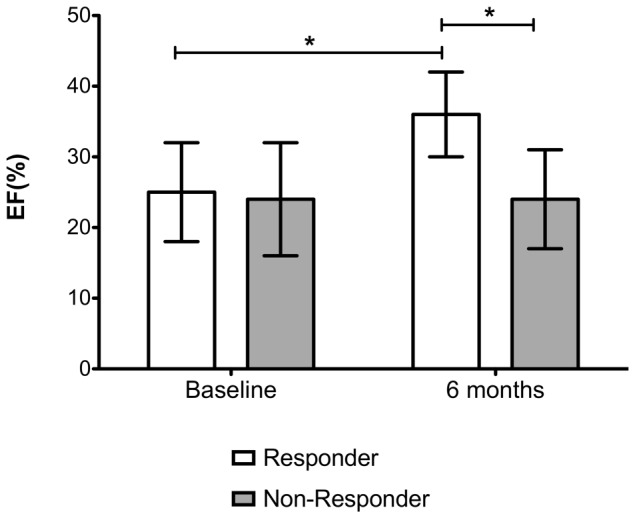
Development of mean left ventricular ejection fraction (EF) in the collectives with and without response to cardiac resynchronization therapy at baseline and at 6 months after device implantation.Error bars indicate standard deviation. While there is no increase in EF in the non-responder group, there is significant improvement in the responder group (* = p<0.0001; see also Table 2).